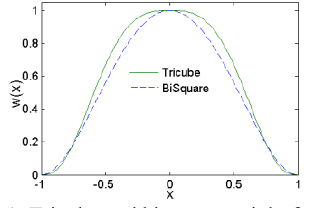
Figure 2. Locally Weighted Regression